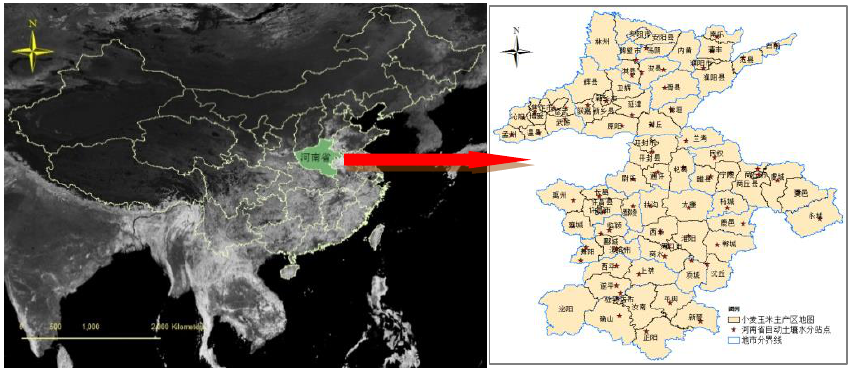
Fig.1 The Sketch Map of Soil Moisture Auto-monitoring Sites